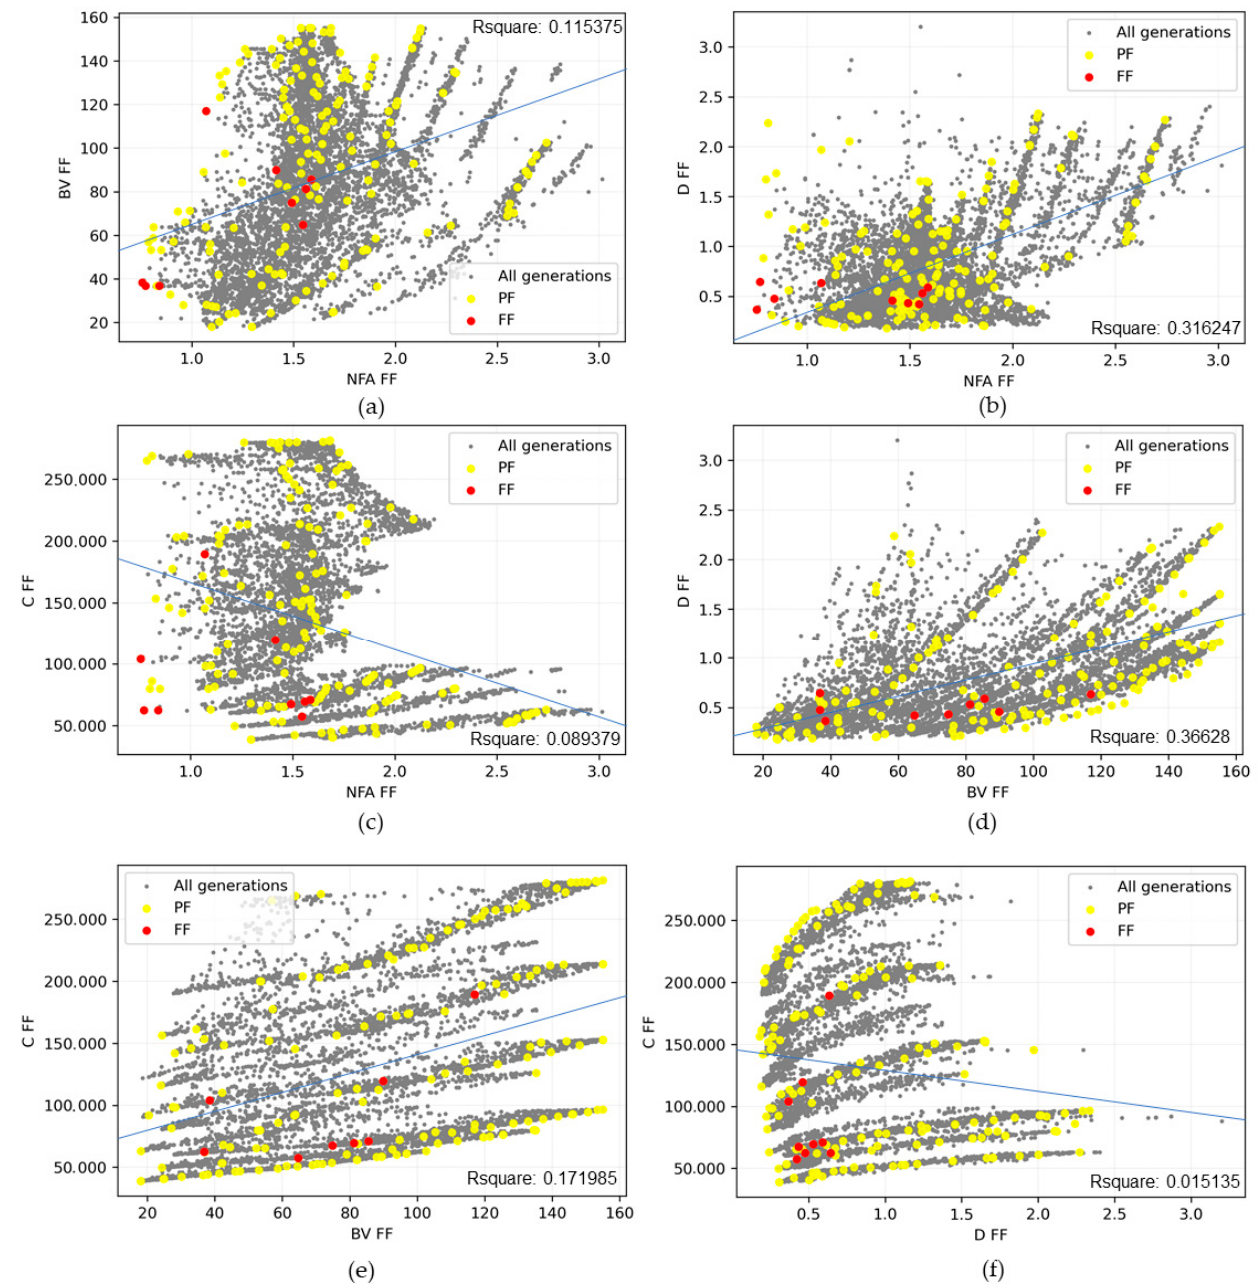
Figure 13 . Scatterplot between two objectives and the Pareto front position: ( a ) NFA and BV; ( b ) NFA and D; ( c ) NFA and C; ( d ) BV and D; ( e ) BV and C; ( f ) D and C.